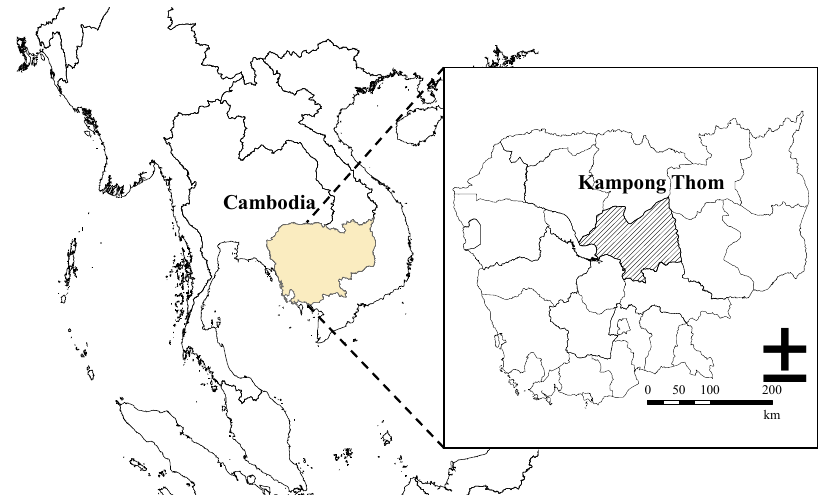
Figure 1. Study area, Kampong Thom Province,